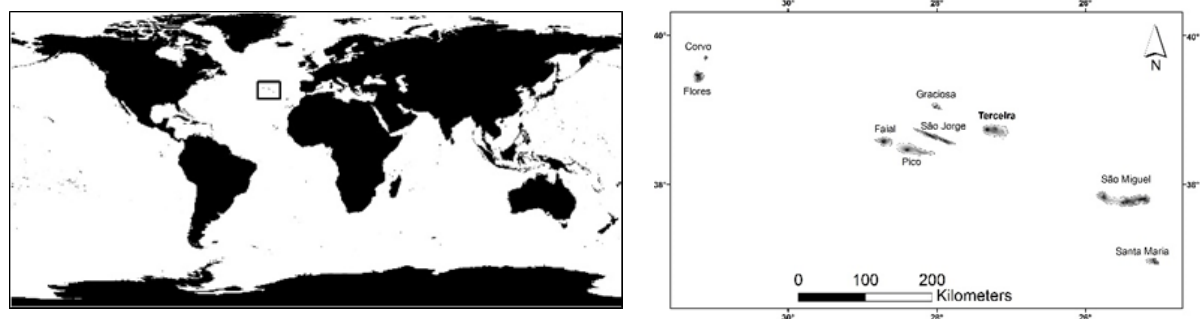
Figure 1. Location of the Azores in the world (left) and map of the Azores archipelago (right) showing the main islands: Corvo and Flores (Western Group); Faial, Graciosa, Pico, São Jorge and Terceira (Central Group); Santa Maria and São Miguel (Eastern